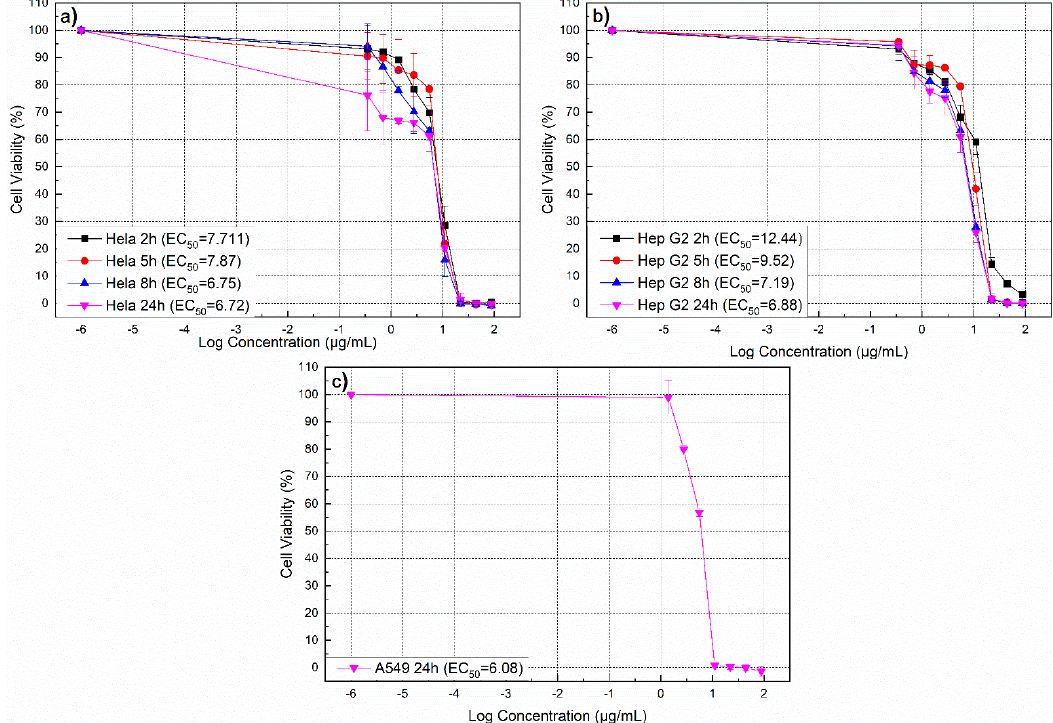
Figure 15. Relative cell viability (%) of ( a ) Hela, ( b ) Hep G2 and ( c ) A549 cells as a function of AgNPs concentration for 2, 5, 8, and 24 h determined by cell titer-blue cytotoxicity assay. The experiments were performed with four replicates and standard deviation was